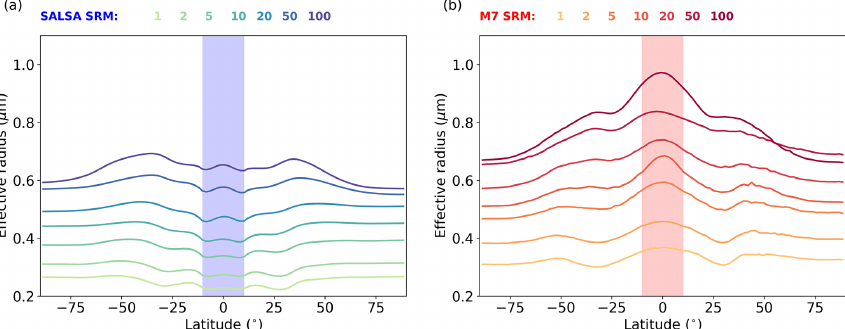
Figure 4. Dependence of the zonal mean effective radius of stratospheric aerosols on the magnitude of sulfur injections simulated with (a) SALSA and (b) M7. The blue and red shaded areas show latitudes where sulfur is